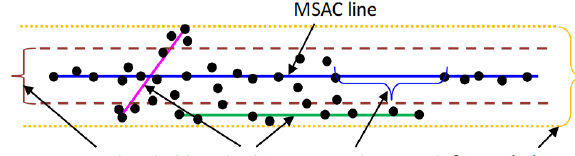
Figure 2 . MSAC line (blue), redundant (false) lines (green and magenta). Black dots are surface points.